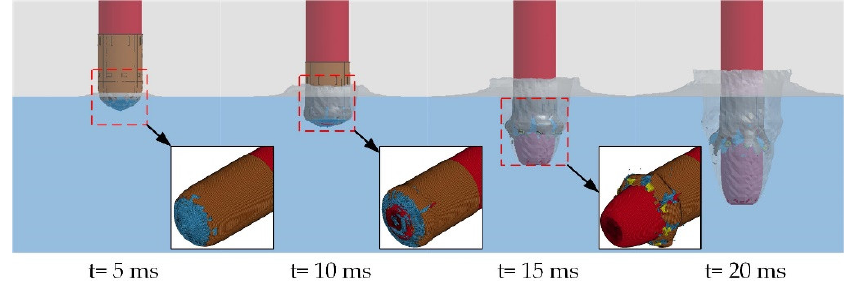
Figure 15. Cavity of vehicle entering water at speed of 100 m/s with head cap.